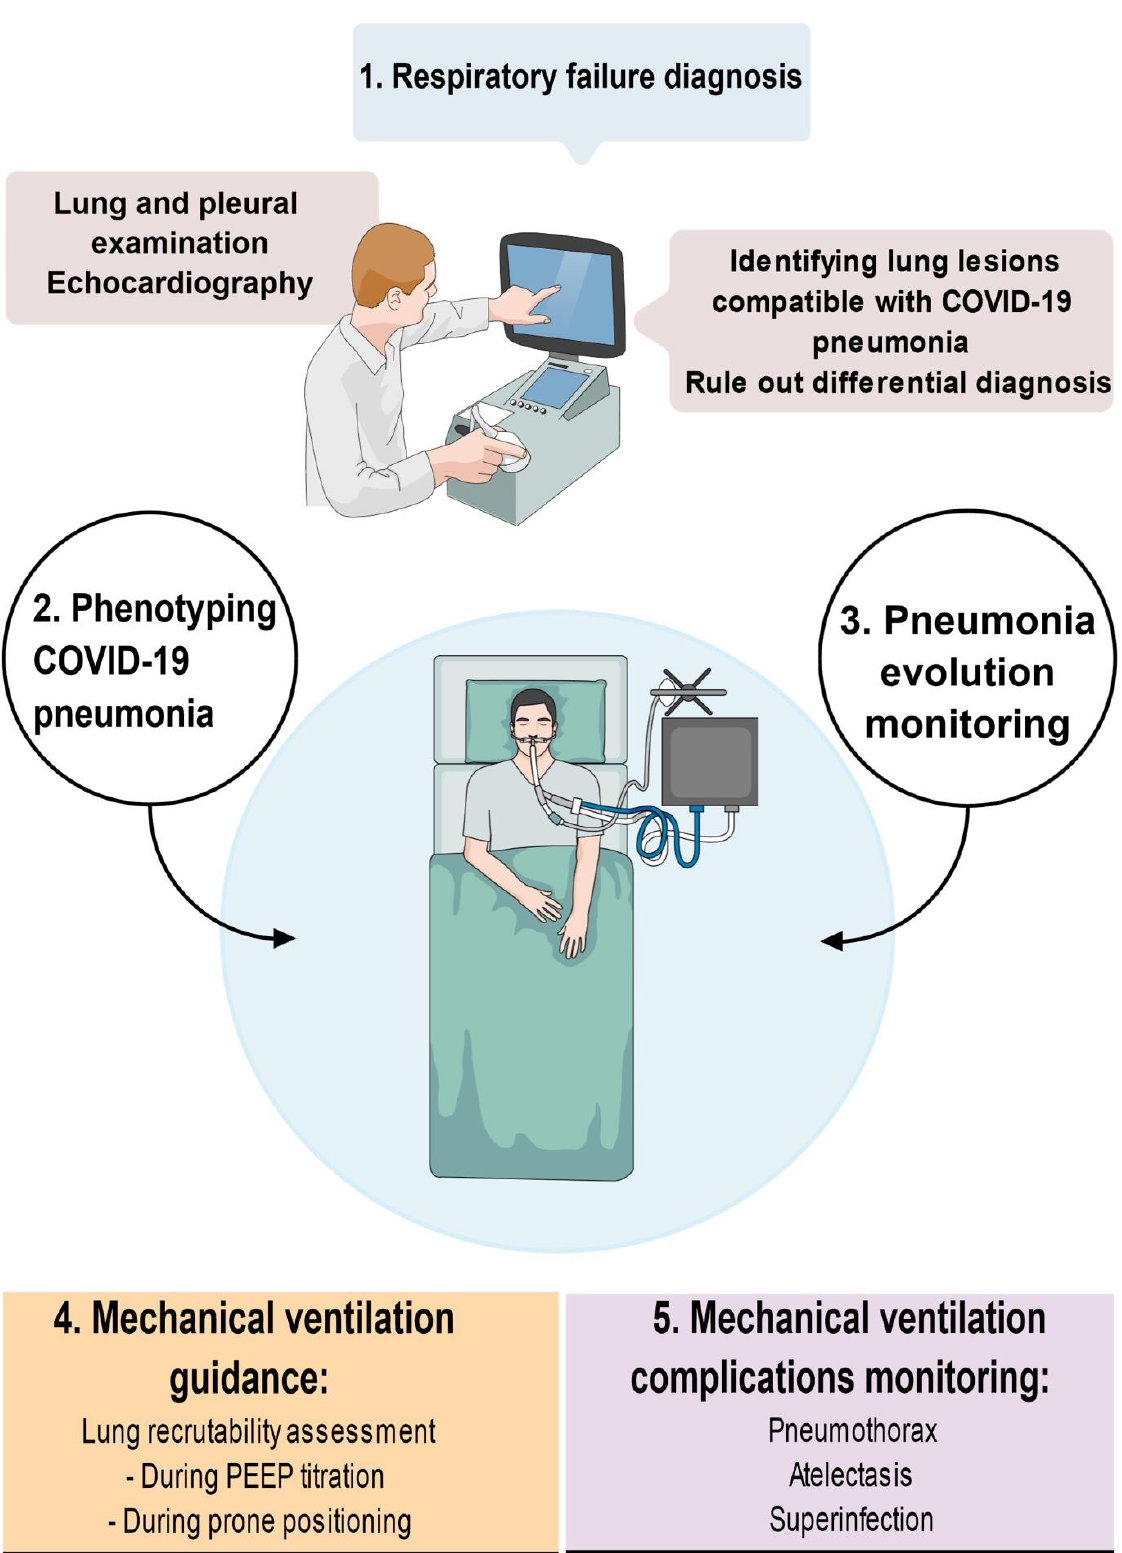
Figure 1. Scope of lung ultrasound in patients admitted with acute respiratory failure and suspected COVID-19